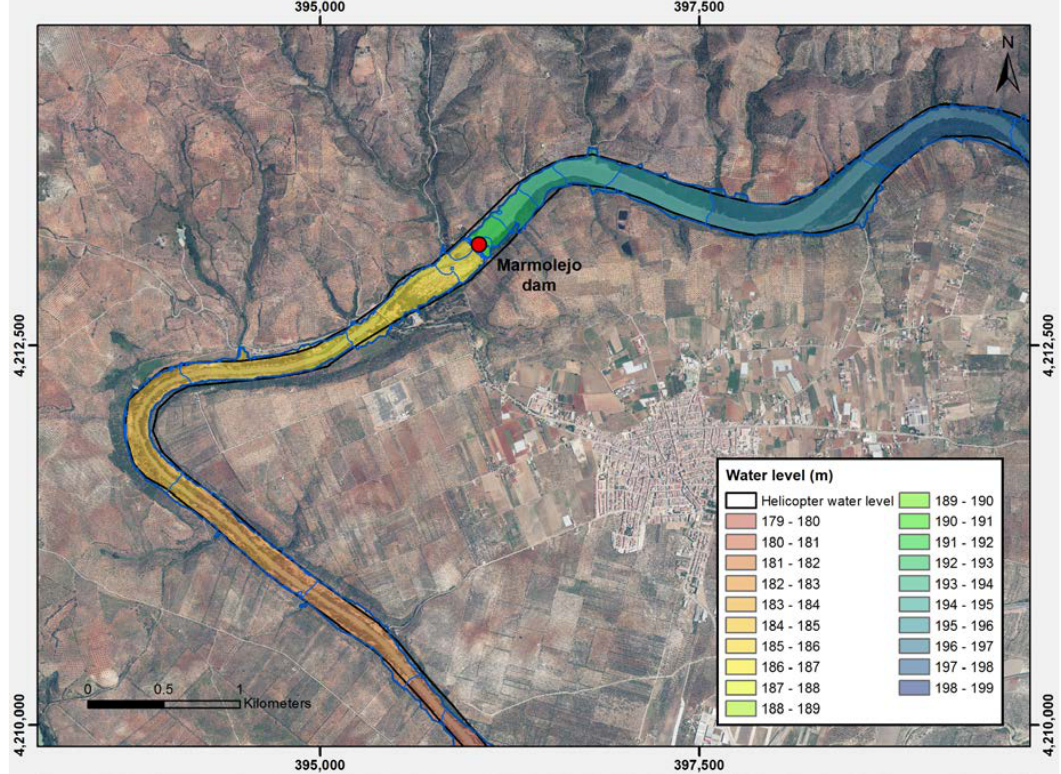
Figure 7. Contours of water elevation from the numerical flood simulation (transparent colour) and inundation perimeter derived based on helicopter flood photograph (black line) on 24 February 2010 at the outlet confined valley crossing Marmolejo dam (red dot). Flow from right to the bottom.